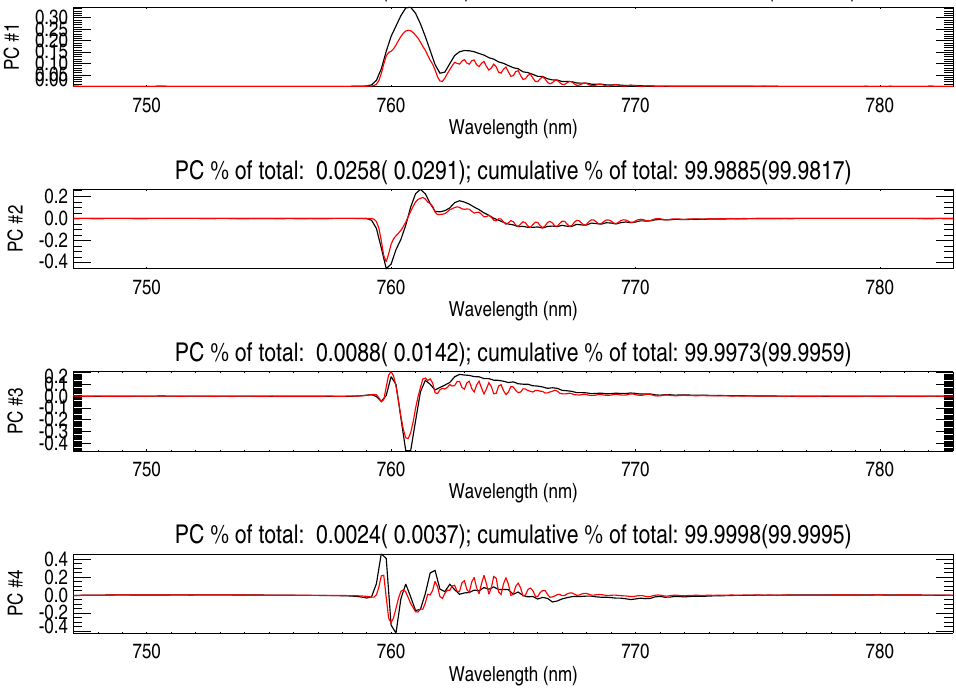
Fig. 7. Similar to Fig. 5 but for the long wavelength fitting window using simulated data.